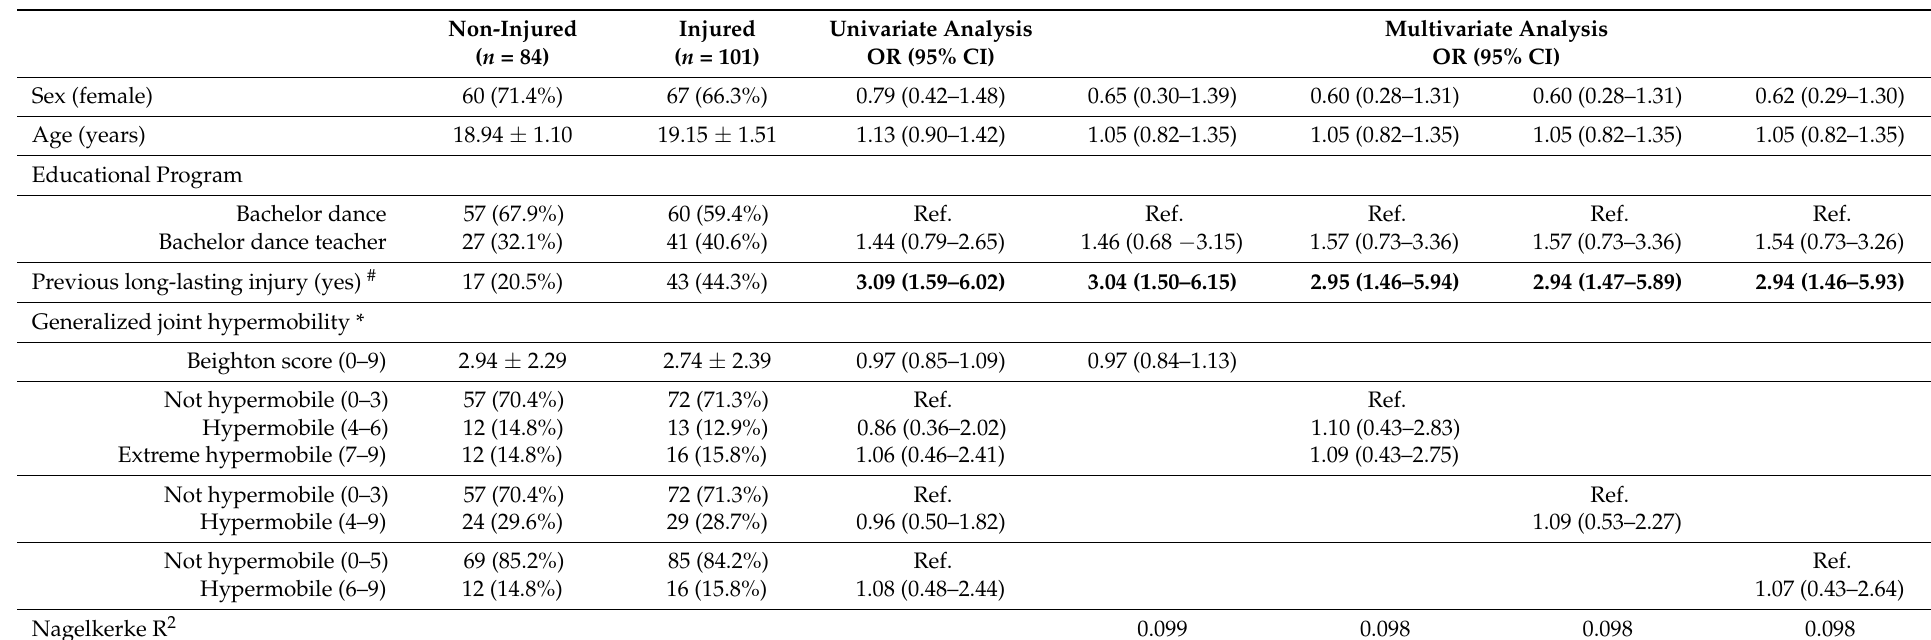
Table 4. Univariate and multivariate models of potential risk factors for time-loss